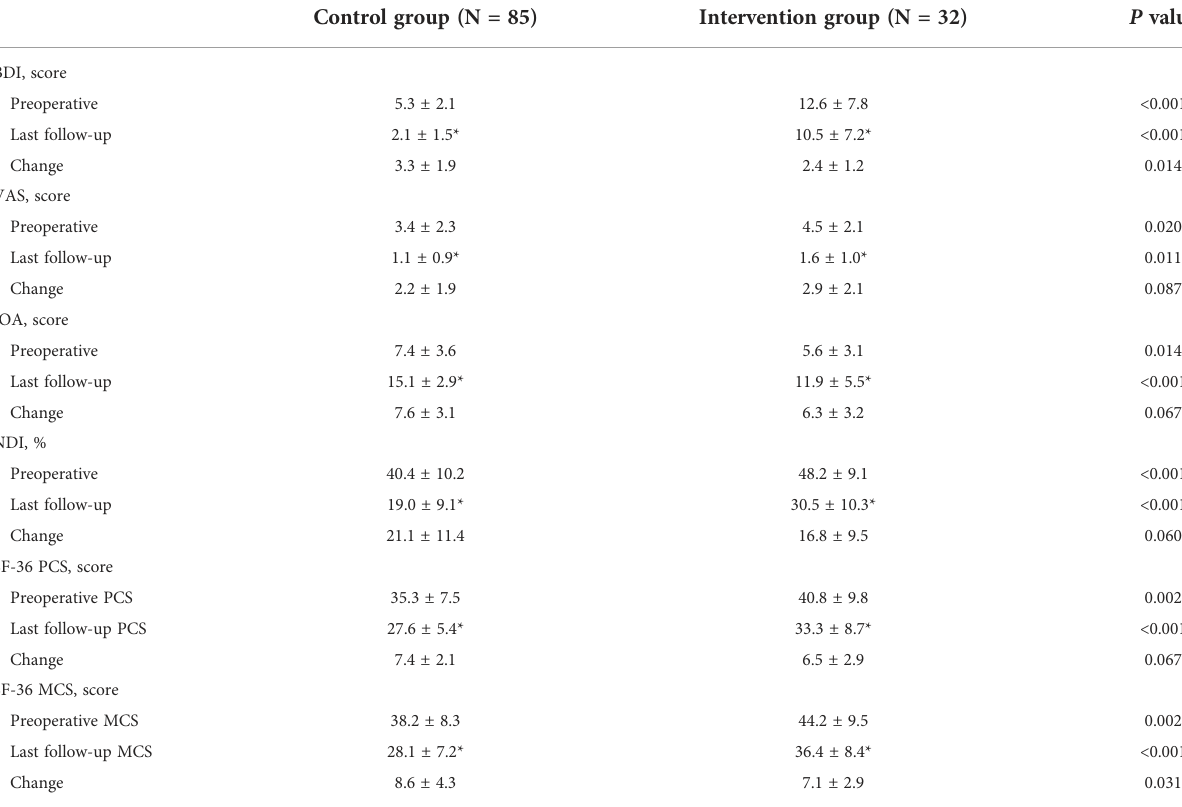
TABLE 2 Comparison of depression, pain, cervical spine function and quality of life between the two